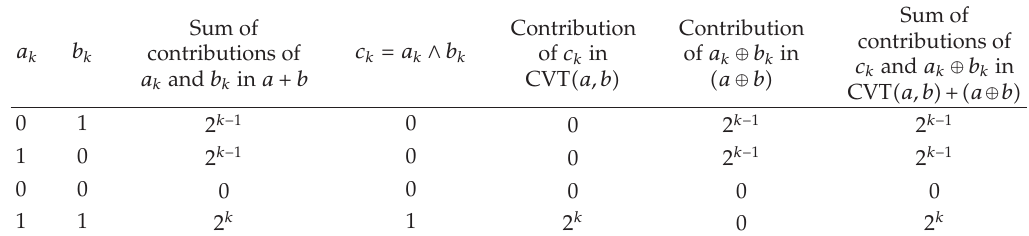
Table 1: Shows the contributions in calculating the sum in di ff erent